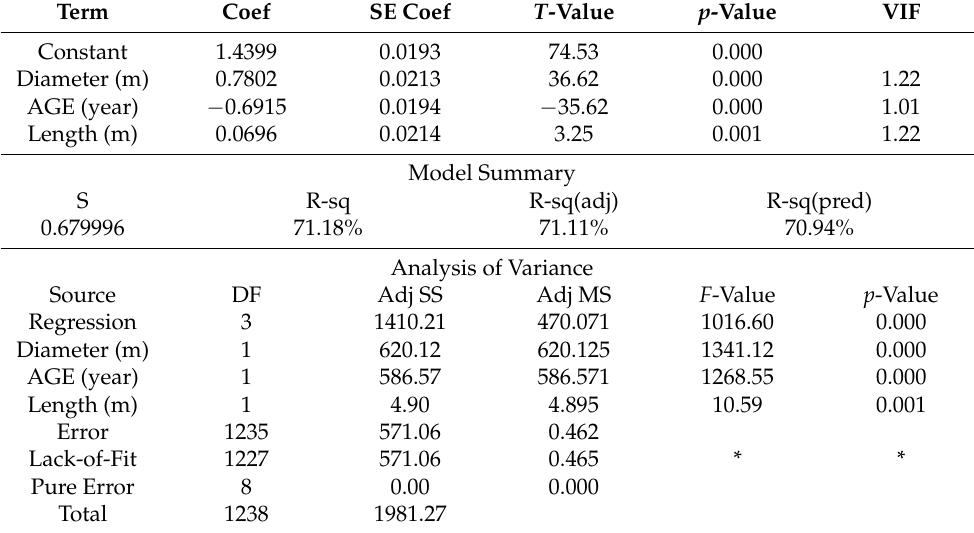
Table 2. Regression analysis of vitrified clay sewer pipe.